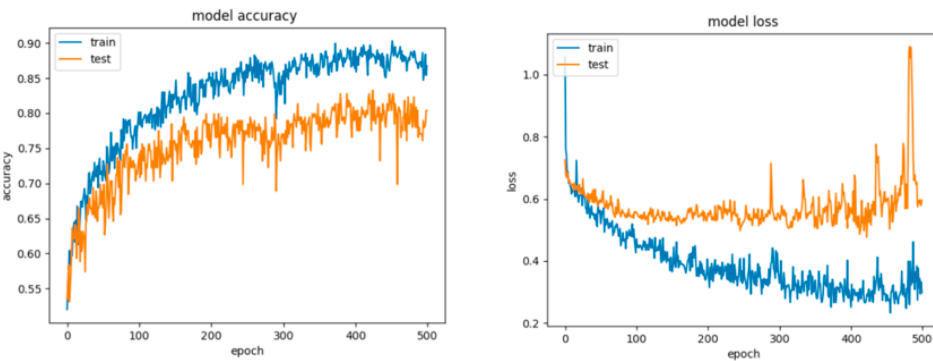
Table 11. Cross-validation and test scores for Configuration 3.